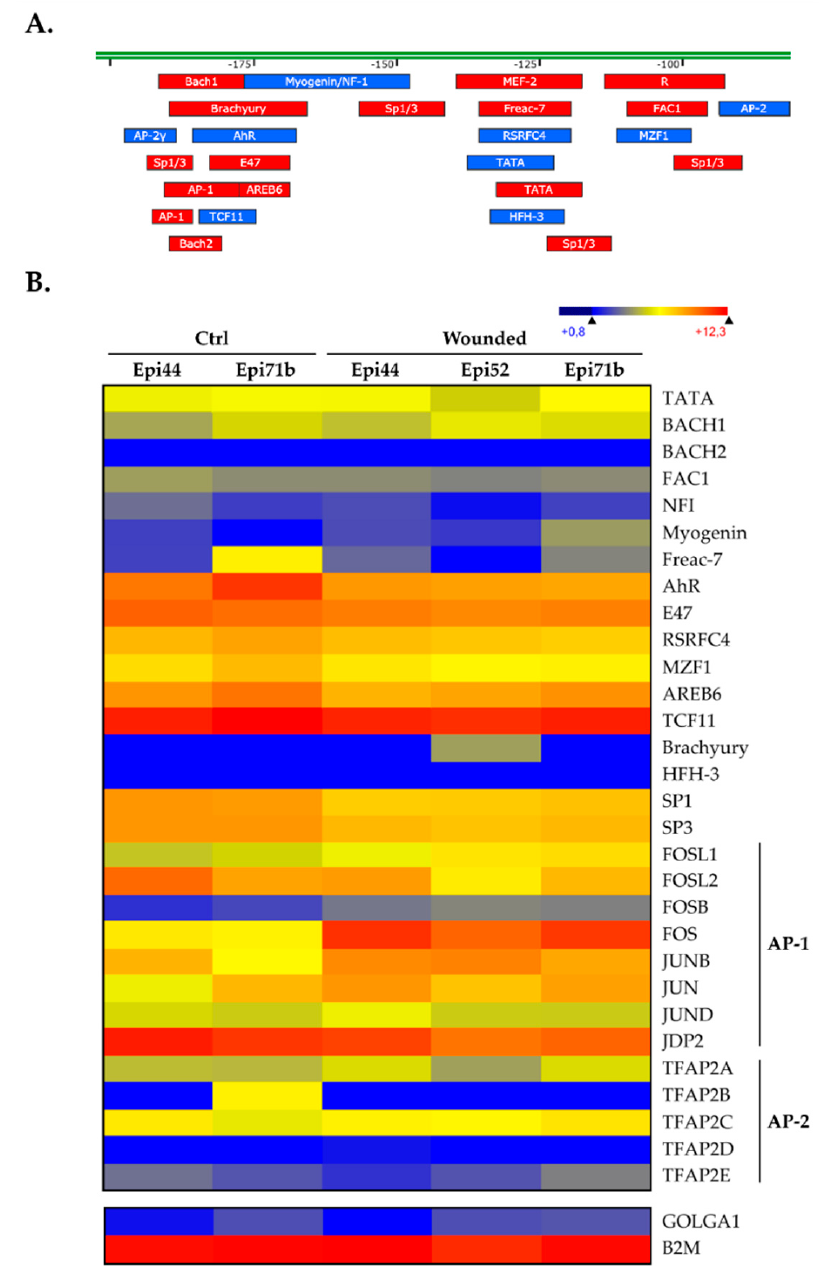
Figure 3. Putative transcription factor binding sites along the CLU promoter sequence. ( A ) Schematic representation of the human CLU promoter -82/-203 segment along which the presumed transcription factor binding sites. TF target sites identified on the DNA top strand are indicated in red, whereas those indicated in blue are located on the bottom strand. ( B ) Heatmap representation of the transcriptional profiles of all the TFs expressed by hTECs for which a putative target site was identified in panel ( A ). Microarray data for B2M and GOLGA1 are also shown as controls.